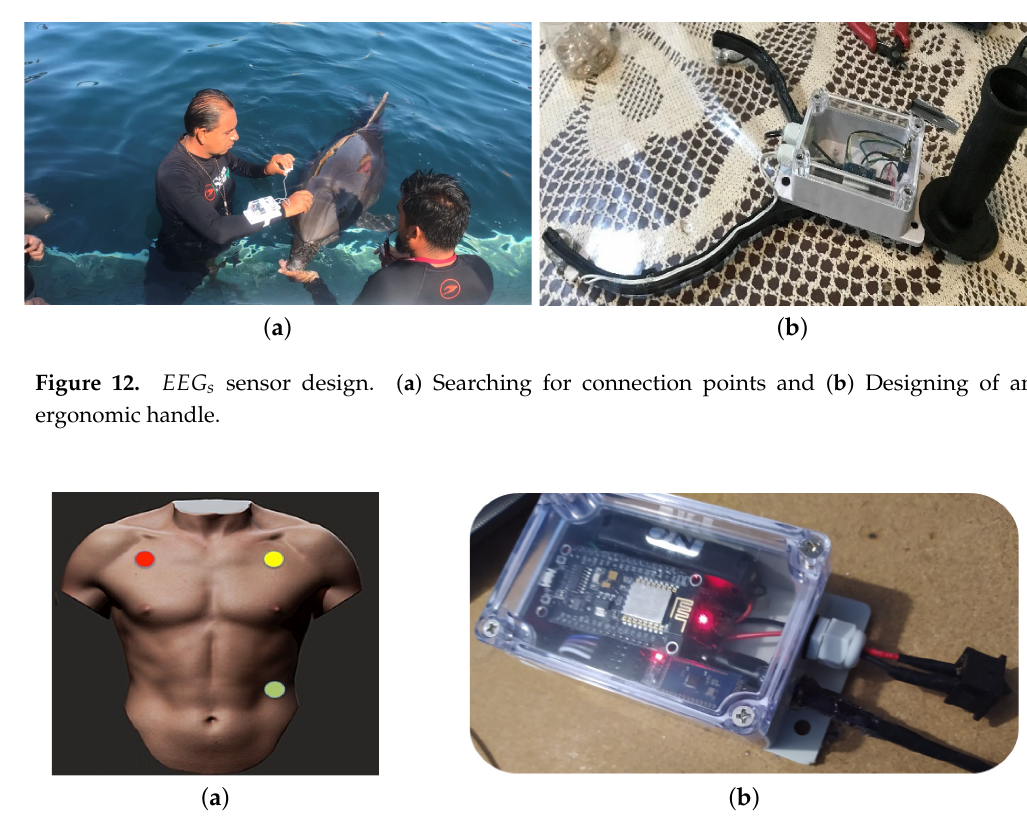
Figure 11. Designing of the waterproof case where TGAM1 Microcontroller is located.